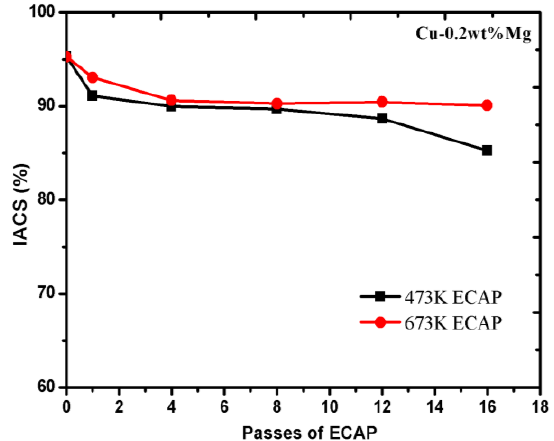
Figure 8. Conductivity of Cu-0.2wt%Mg alloy variation with the passes of ECAP at 473 K and 673